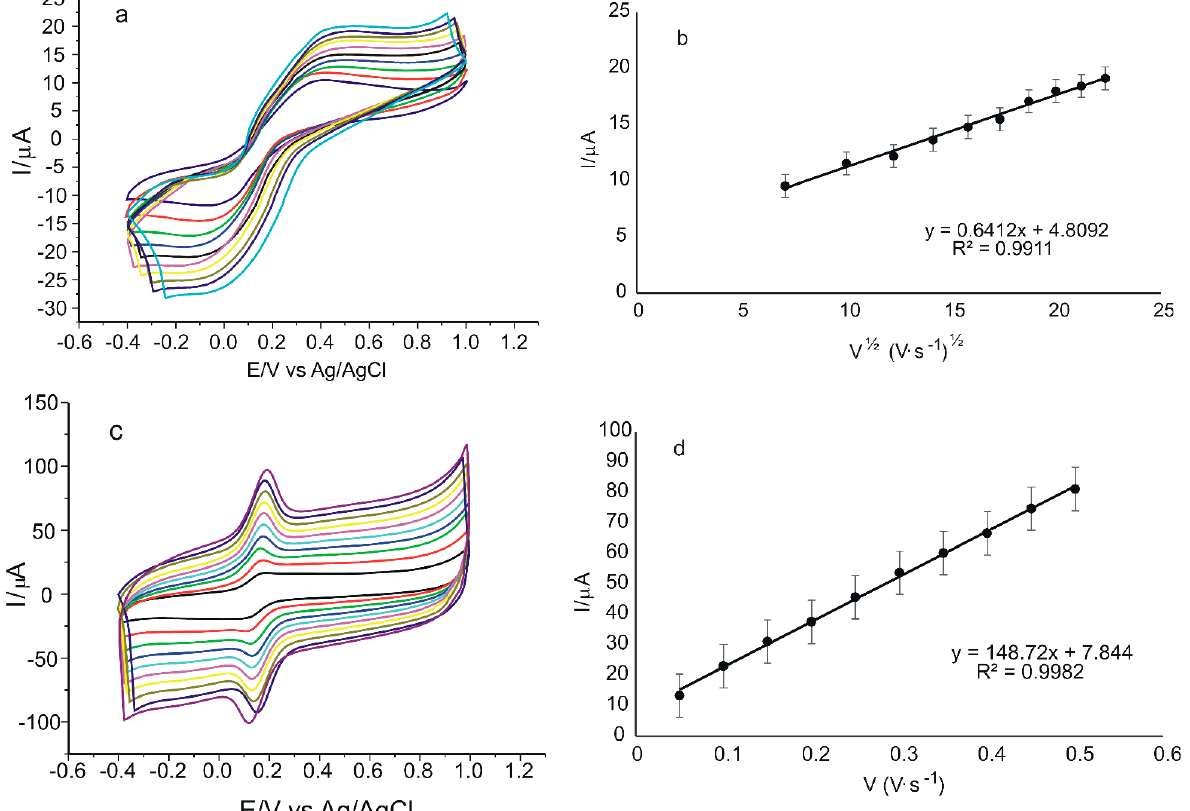
Figure 7. CVs of SPCE/GPHOX ( a ) and SPCE/GPHOX-Pentapeptide ( c ) immersed in 10 − 3 M K 4 [Fe(CN) 6 ]/K 3 [Fe(CN) 6 ]–0.1 M PBS solution at pH = 6.5 recorded at scan rates between 0.05 and 0.5 V · s − 1 . Linear dependence of Ipa and square root of scan rate in the case of SPCE/GPHOX ( b )